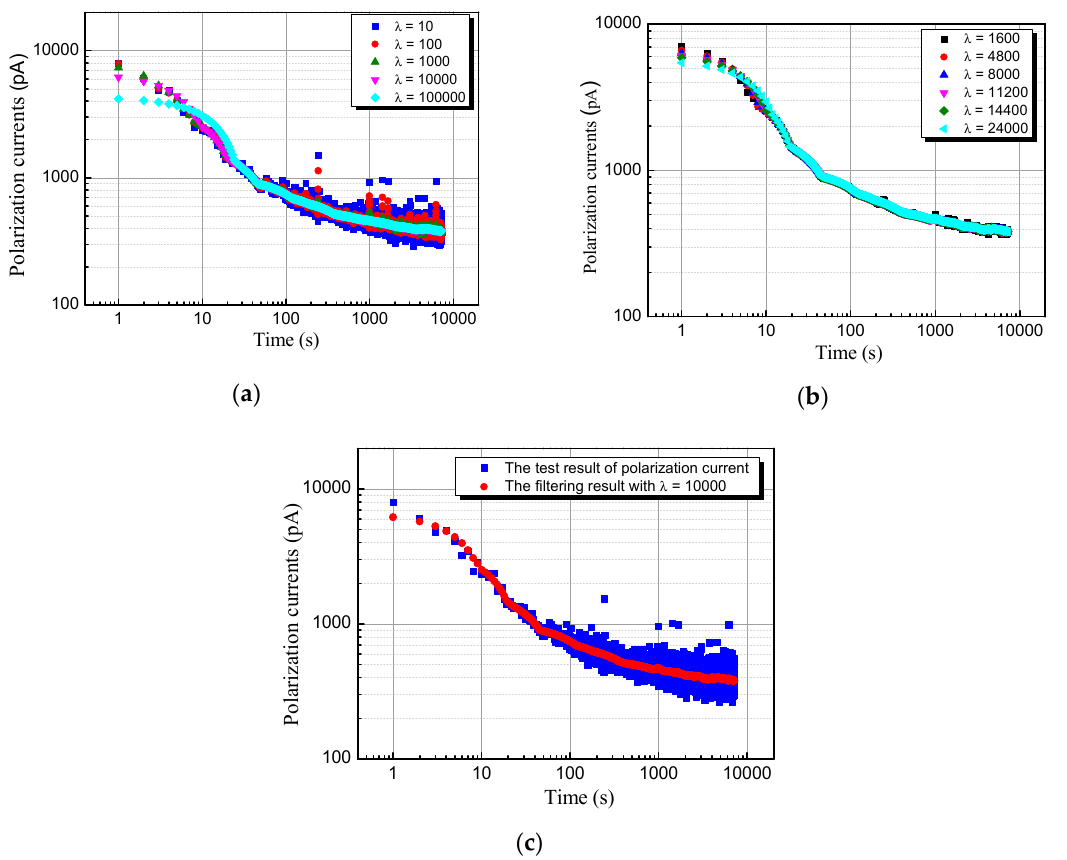
Figure 3. The diagram of L1 trend filtering result: ( a ) The filtering results with λ value of 10–100,000; ( b ) the filtering results with λ value of 1000–30,000; and ( c ) the filtering results with λ = 10,000.